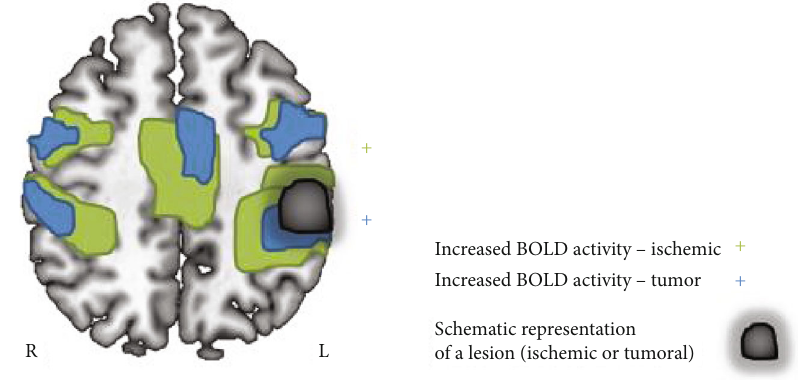
Figure 4: Schematic representation of the major mechanisms of functional reorganization of motor function in the subacute phase of a stroke lesion and postoperatively in a tumor lesion. Functional MRI activations of primary and secondary motor areas during the subacute phase of a stroke lesion (green color) and postoperatively in a low-grade glioma (LGG) (blue color) in the left precentral region. Comparison of two models of reorganization shows a similar pattern of motor-activated areas, but an overactivation of ipsilesional and contralesional areas (M1, premotor area, and supplementary motor area) is evident in ischemic lesion compared to